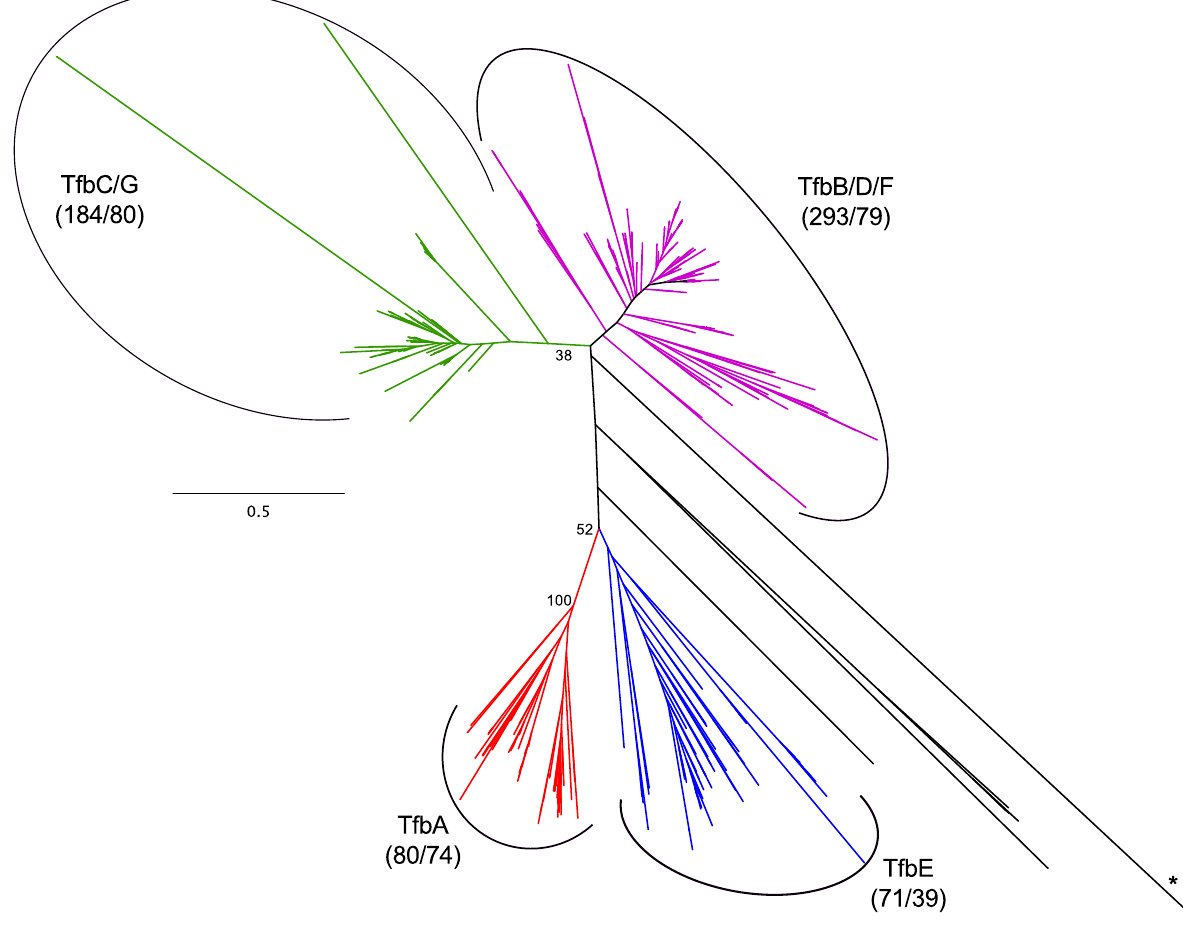
Figure 9. Haloarchaeal transcription factor B phylogeny. Unrooted phylogenetic tree of haloarchaeal transcription factor B (TFB) homologs. Green - TfbC/G, magenta - TfbB/D/F, blue - TfbE, red- TfbA, black - unassigned.Numberof sequencesandspecies represented ineach clade areshownin parenthesis. Bootstrap support values over 30% are shown for major clades. Branch marked with asterisk is truncated. See Dataset S5 for tree file.